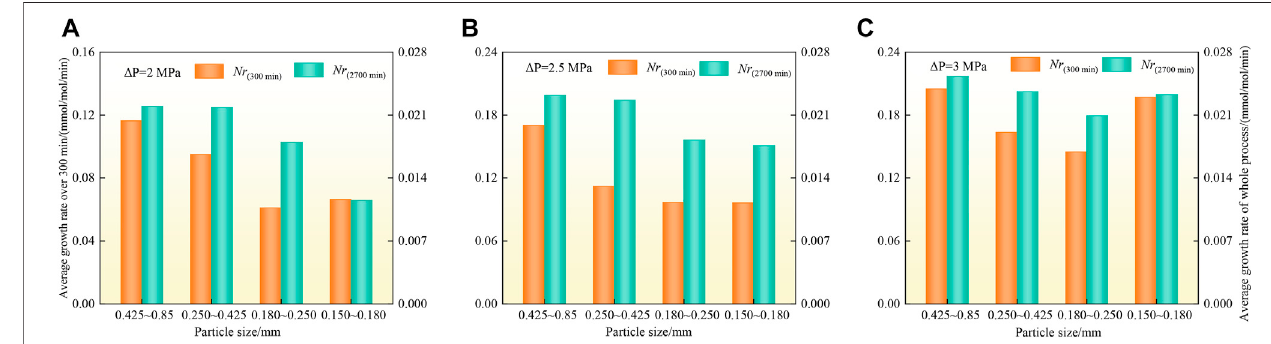
FIGURE 7 | Histogram comparing the average growth rate of CO 2 hydrates in the 2, 2.5 and 3 MPa systems.